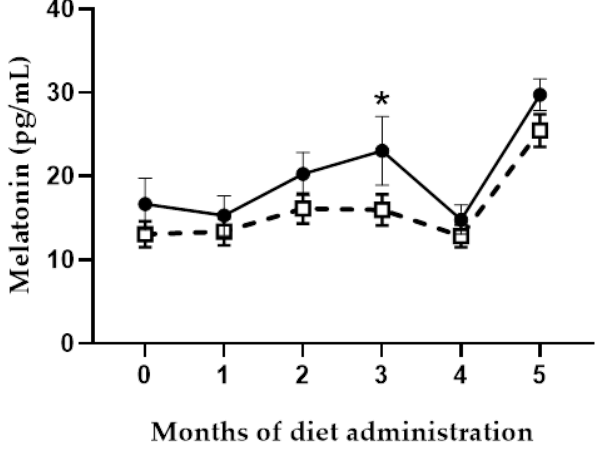
Figure 1. Monthly variations of melatonin levels in seminal plasma of animals fed with a phy- tomelatonin- rich (●) or commercial (control, □) diet from month 0 (before diet administration) to month 5. Values are shown as mean ± S.E.M., n = 16. * p < 0.05 indicates significant differences between both experimental groups.